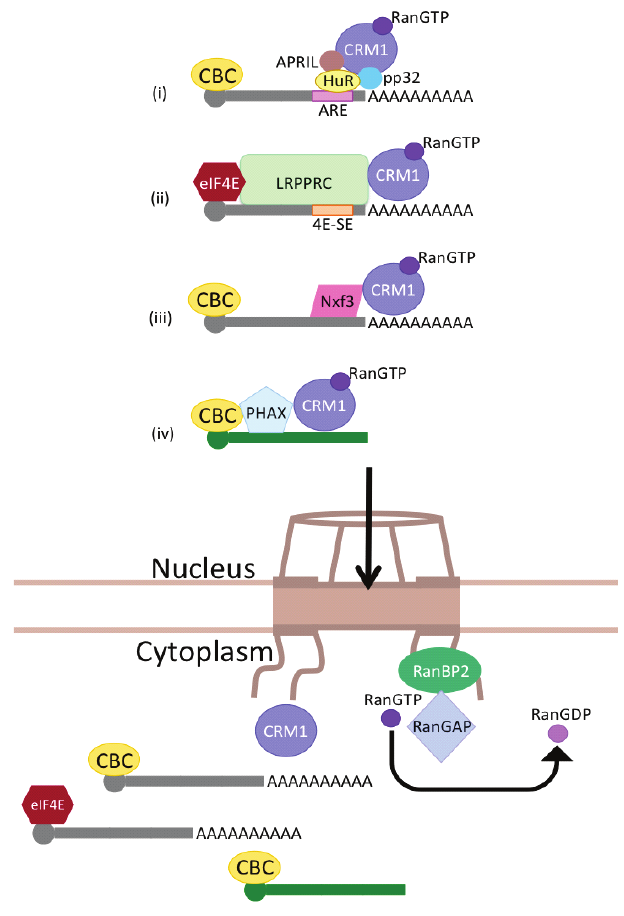
Figure 3. Crm1-dependent mRNA export. Several subsets of mRNA are exported by